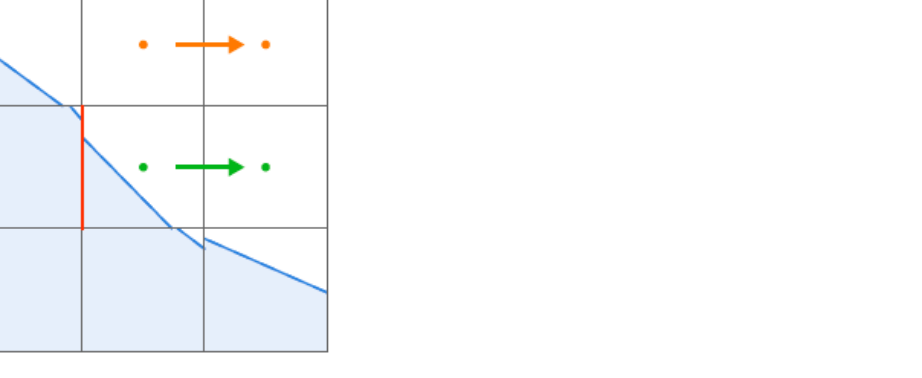
Figure 2. The calculation of temperature gradient. (The red surface is to be the calculated surface, and the gradient values of the green and yellow surfaces are used for approximation).